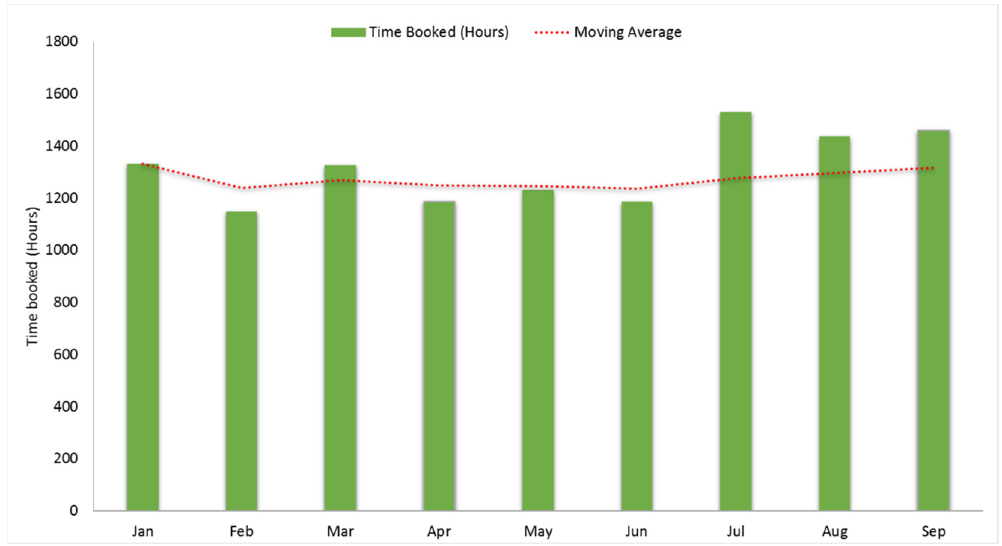
Figure 18. KPI (key performance indicator)—Capacity (monthly electronic products tested).